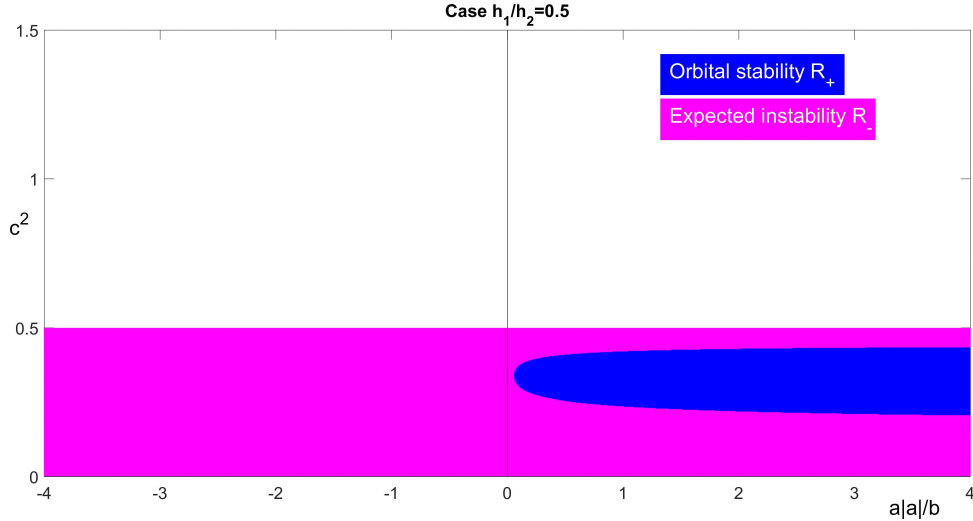
∈ ( -4,4 ) and c 2 ∈ ( 0,0.5 ) : b